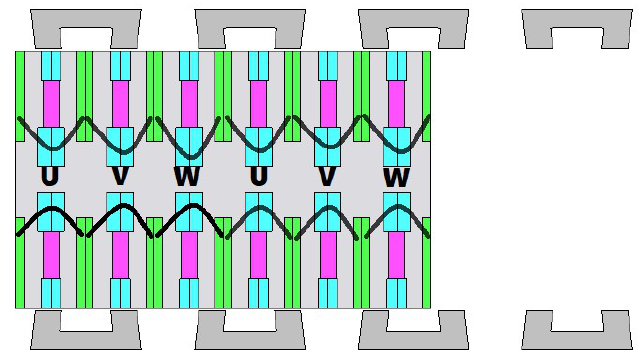
Figure 6. Winding configuration of the proposed model.